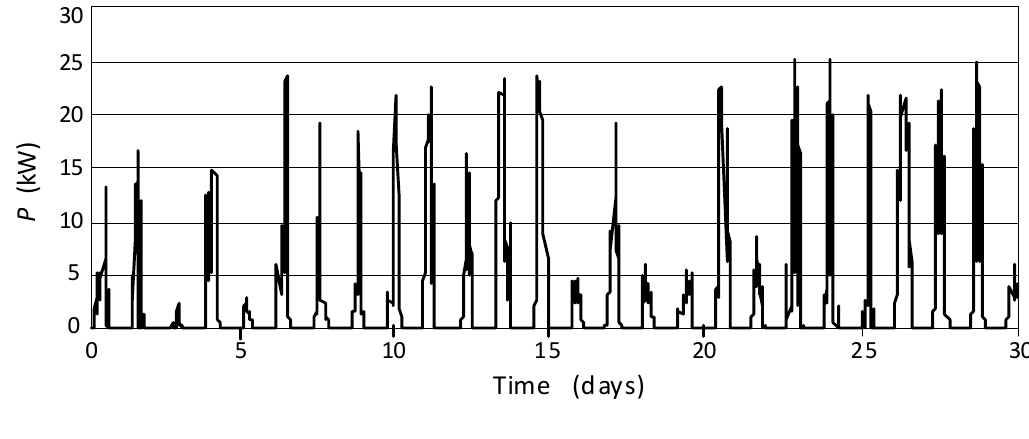
Figure 5. Variation of PV system power output during a